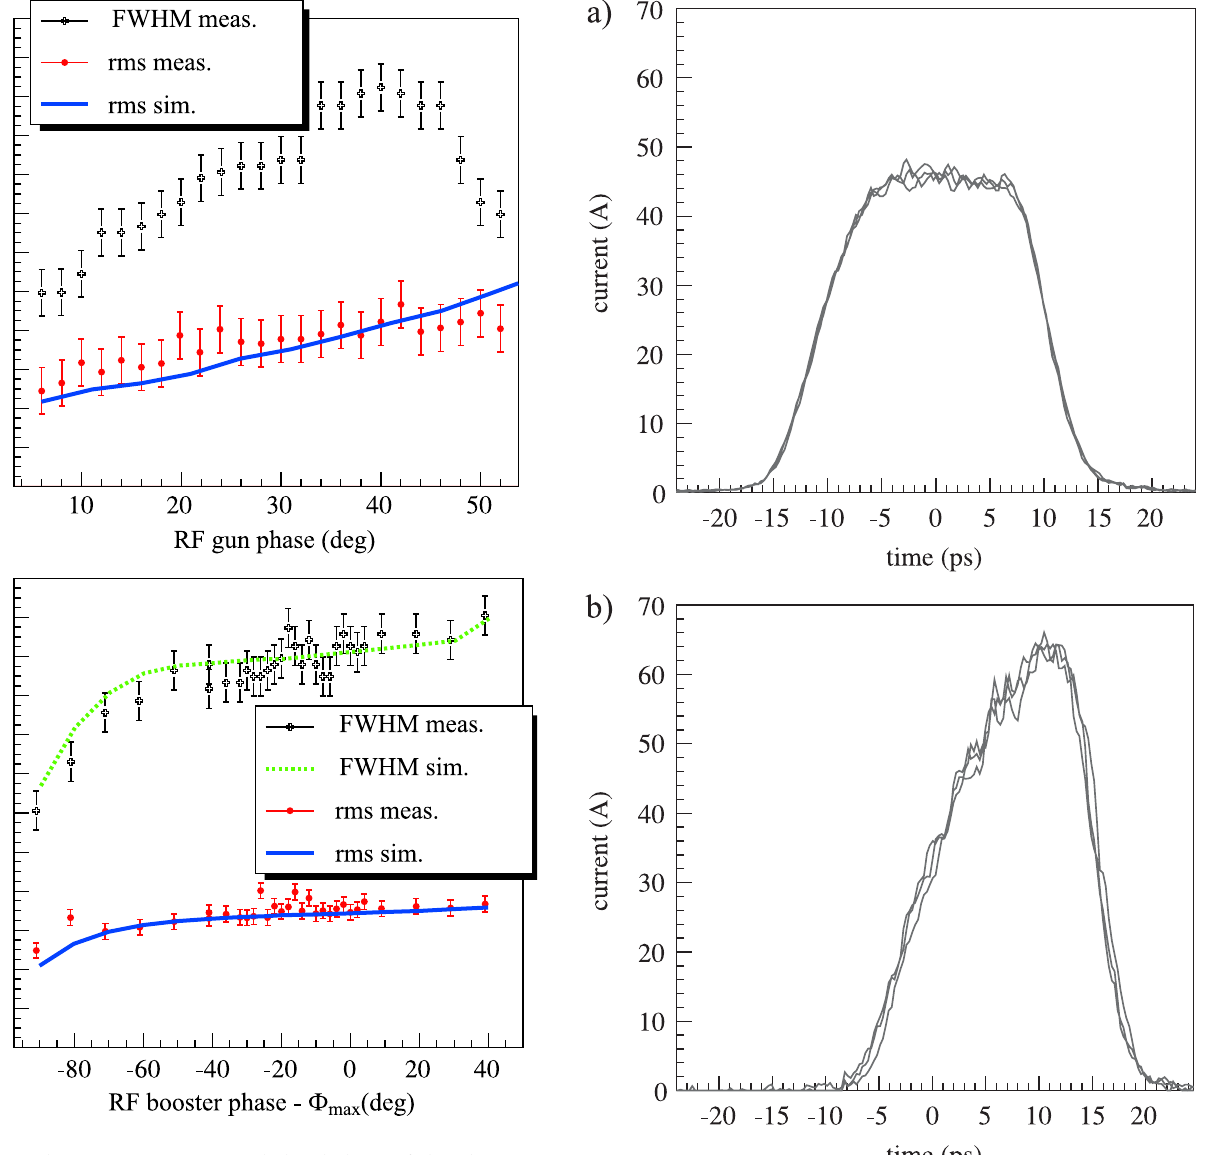
FIG. 26. (Color) Measurements and simulations of the electron bunch length as a function of the gun (a) and booster phase (b).